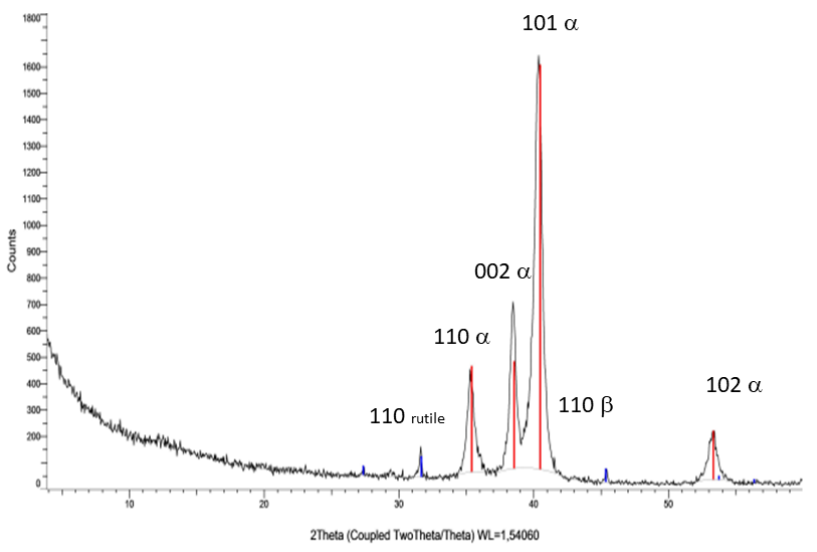
Figure 4. X-ray diffraction spectrum of the metal debris.